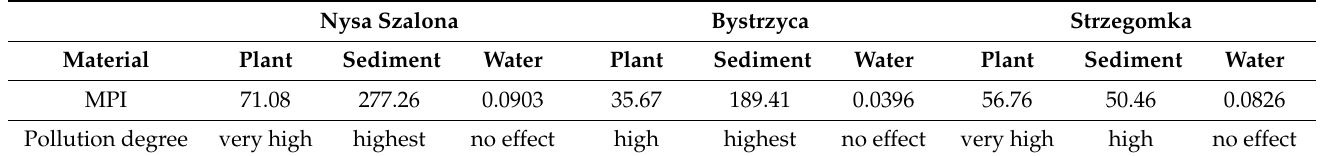
Table 5. Metal pollution index (MPI) of aquatic plants, bottom sediments, and water with aluminum [24,25]. Nysa Szalona